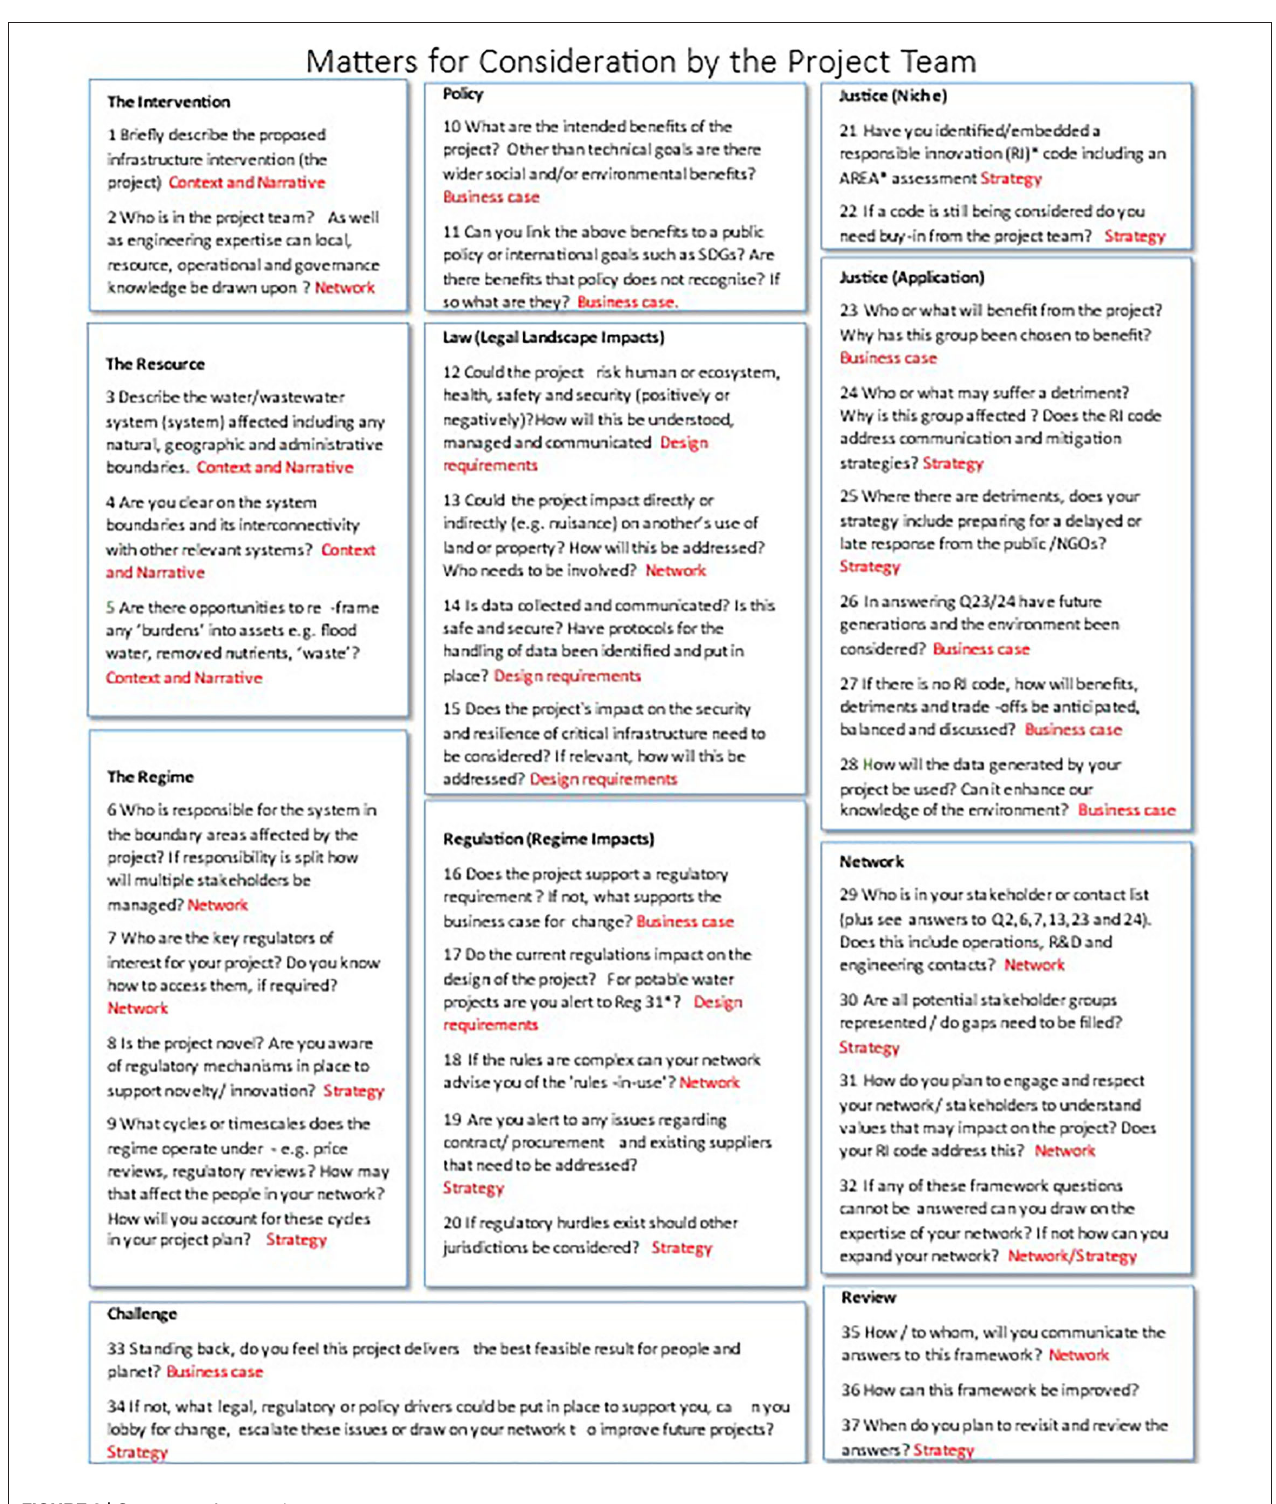
FIGURE 3 | Governance